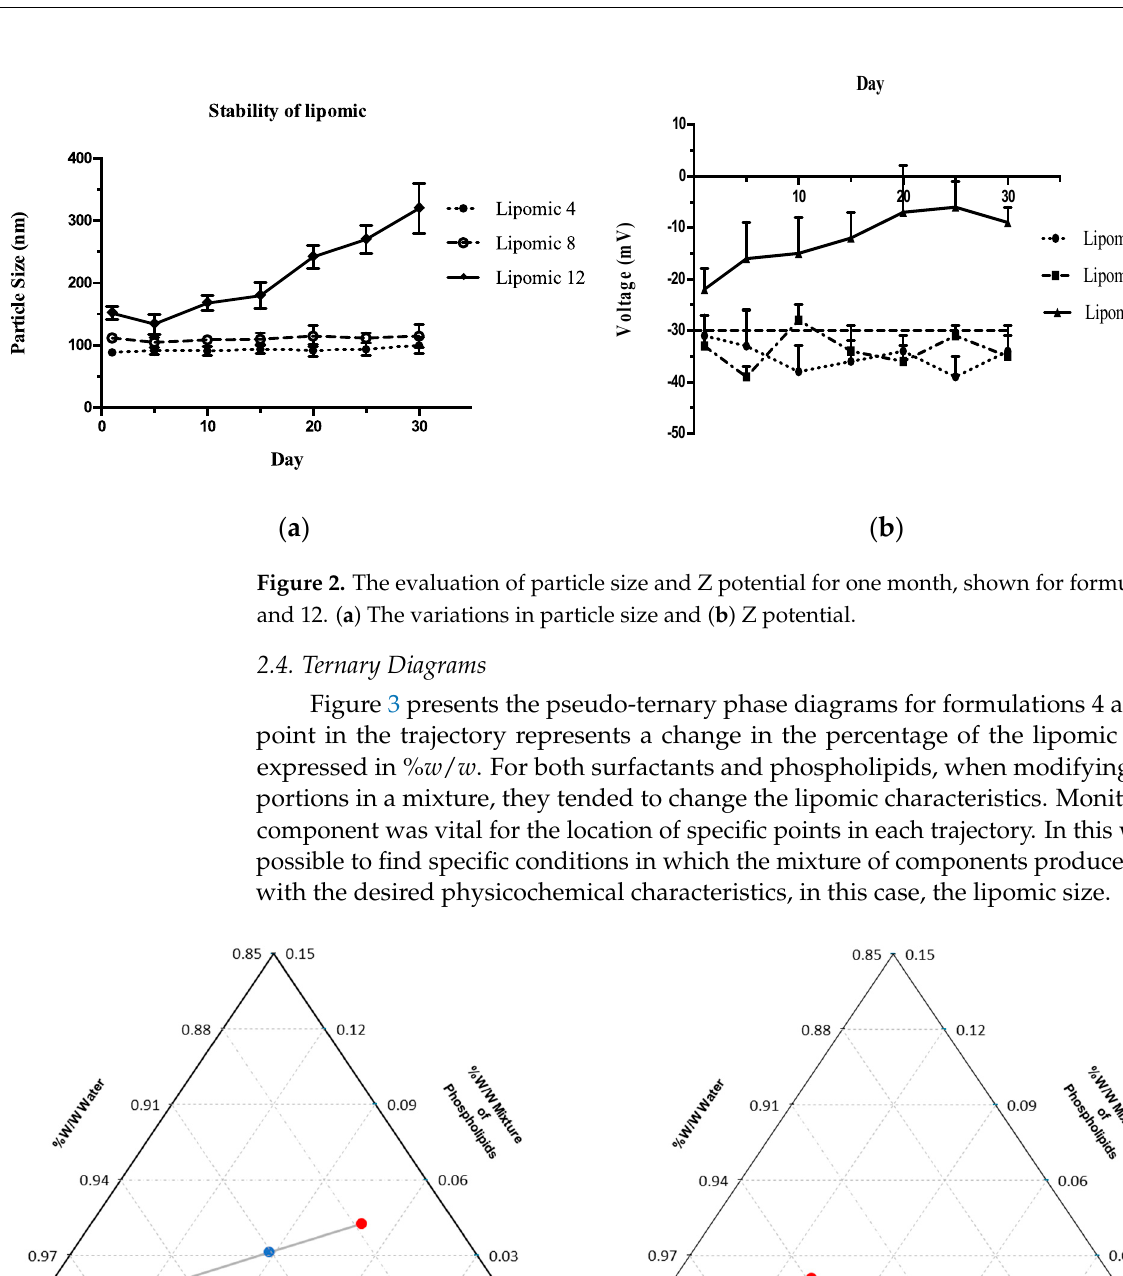
Figure 3. Pseudo-ternary phase diagrams: ( a ) the trajectories for formulation 4 and ( b ) formulation 8.